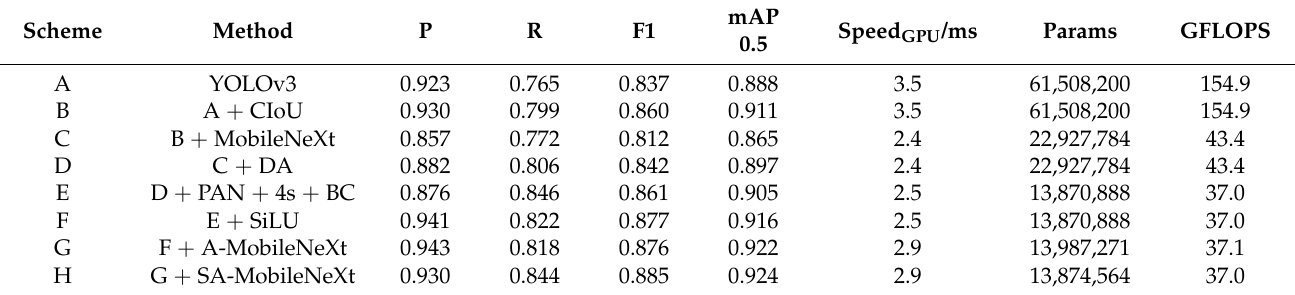
Table 1. The ablation experiments on the KITTI dataset. Sche